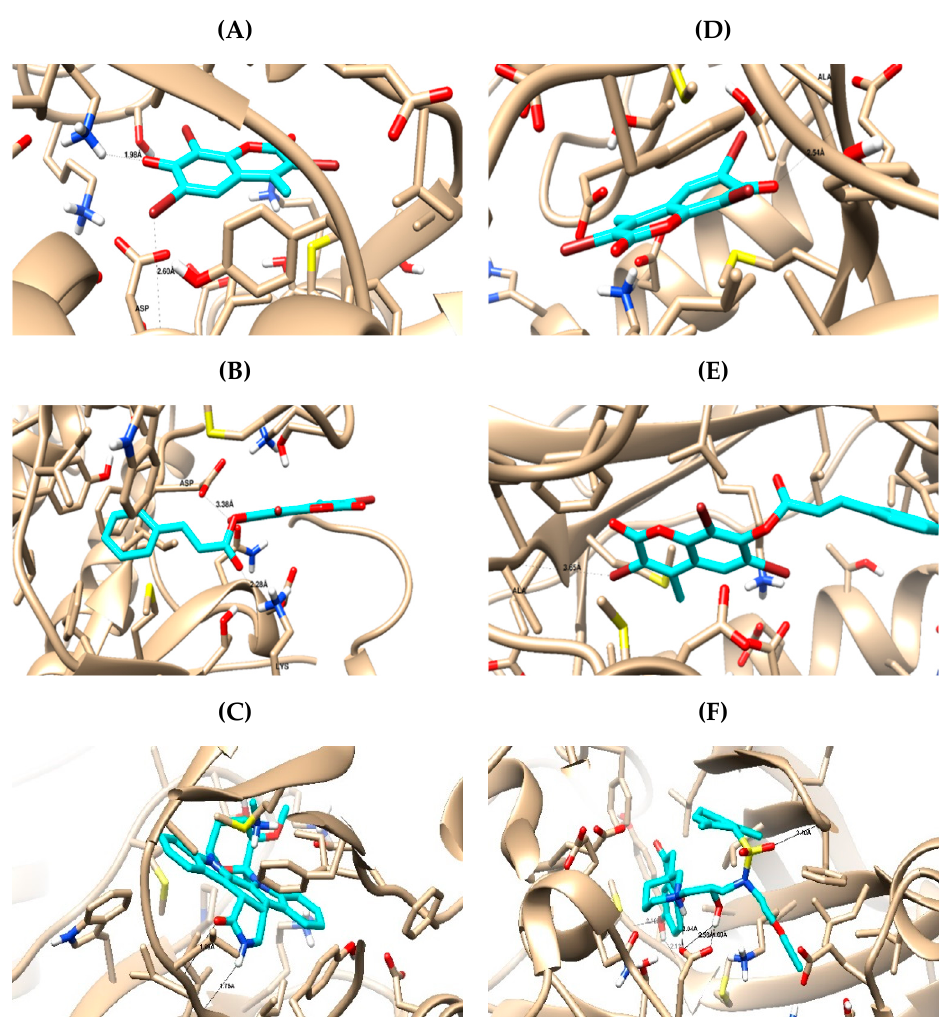
Figure 13. 3D presentation of docked compounds (cyan-highlighted) inside the binding site of tested proteins; ( A ) compound 4 bound to PI3K key amino acid residues in the active site, ( B ) compound ( 8b ) bound to PI3K key amino acid residues in the active site, ( C ) staurosporine (control) bound to PI3K key amino acid residues in the active site, ( D ) compound ( 4 ) bound to AKT key amino acid residues in the active site, ( E ) compound 8b bound to AKT key amino acid residues in the active site, ( F ) spirochromane derivative (control) bound to AKT key amino acid residues in the active site.